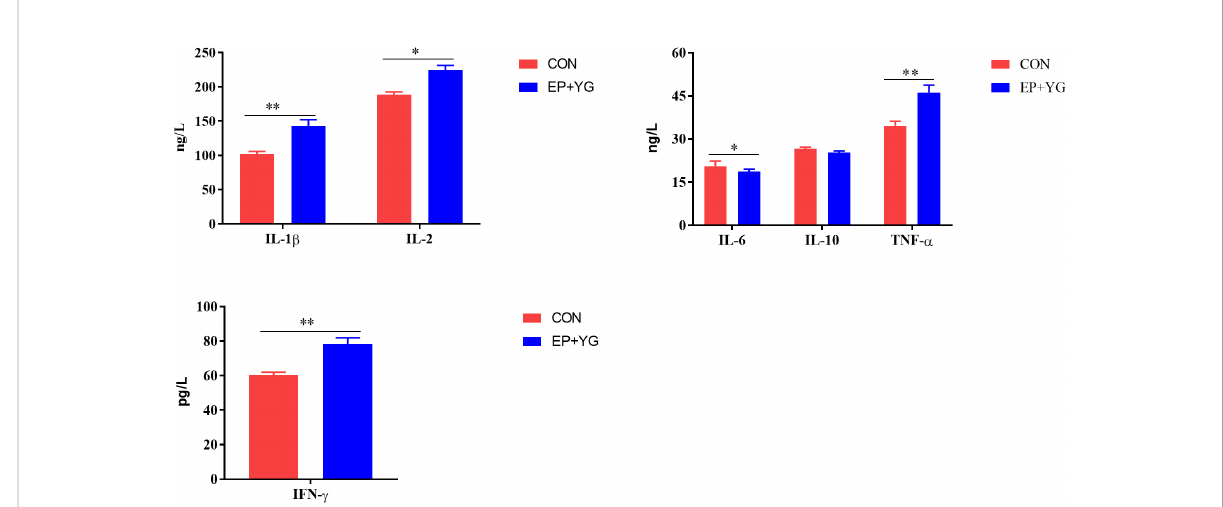
FIGURE 1 The effect of dietary EP+YG inclusion on the serum cytokine levels of broiler chickens. Data are presented as mean ± SEM, n = 8. * P < 0.05 and ** P < 0.01. IL-1 b , Interleukin 1 beta; IL-2, Interleukin 2; IL-6, Interleukin 6; IL-10, Interleukin 10; TNF- a , Tumor necrosis factor-alpha; IFN-